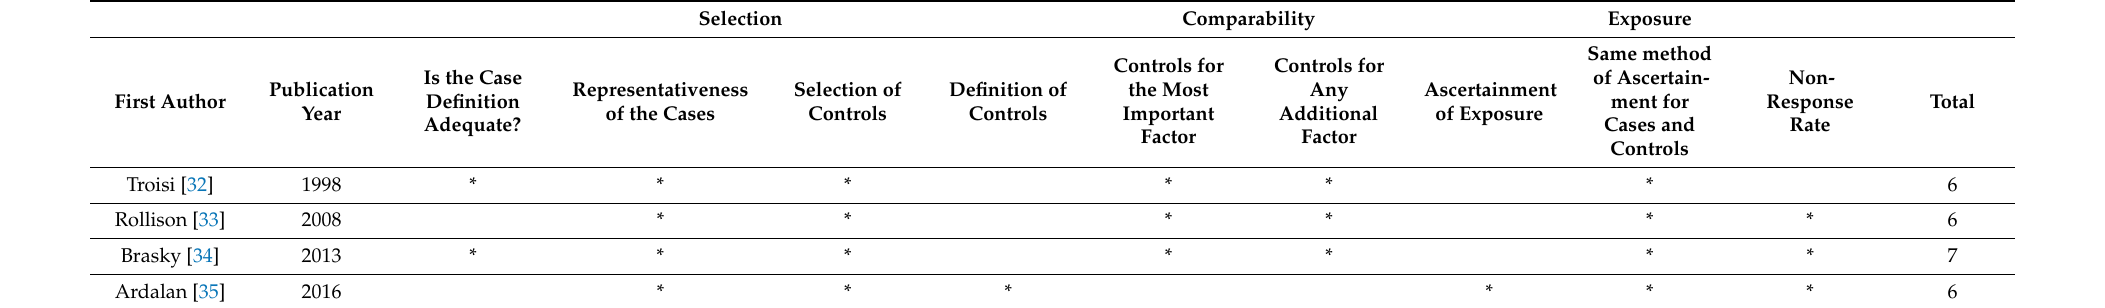
Table 4. Risk of bias and quality assessment of case-control